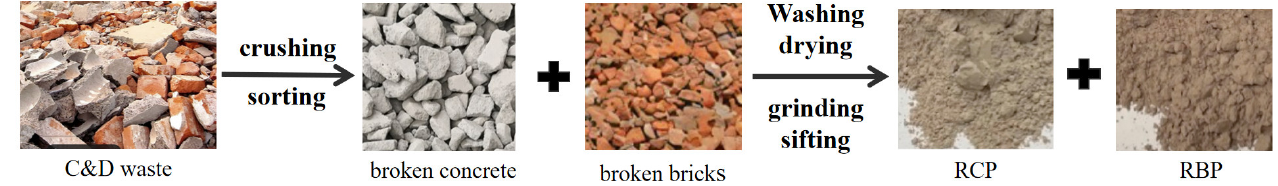
Figure 1. Recycled powder preparation flow chart.